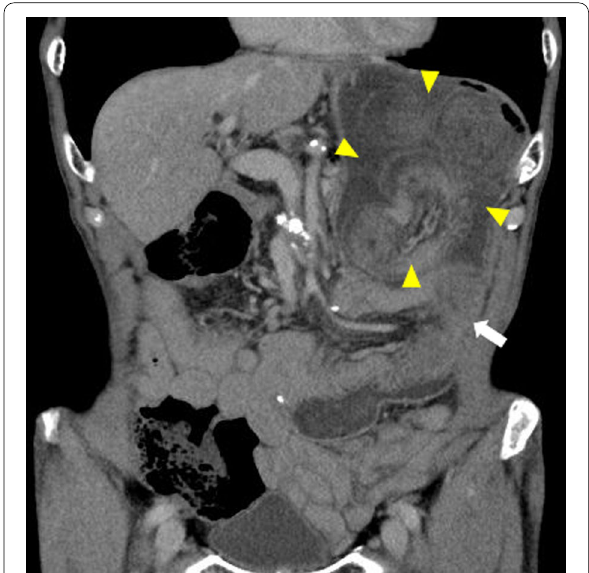
Fig. 1 Contrast-enhanced computed tomography revealed that the small intestine (arrow), which had an edematous wall with poor contrast enhancement, had invaginated into the remnant stomach